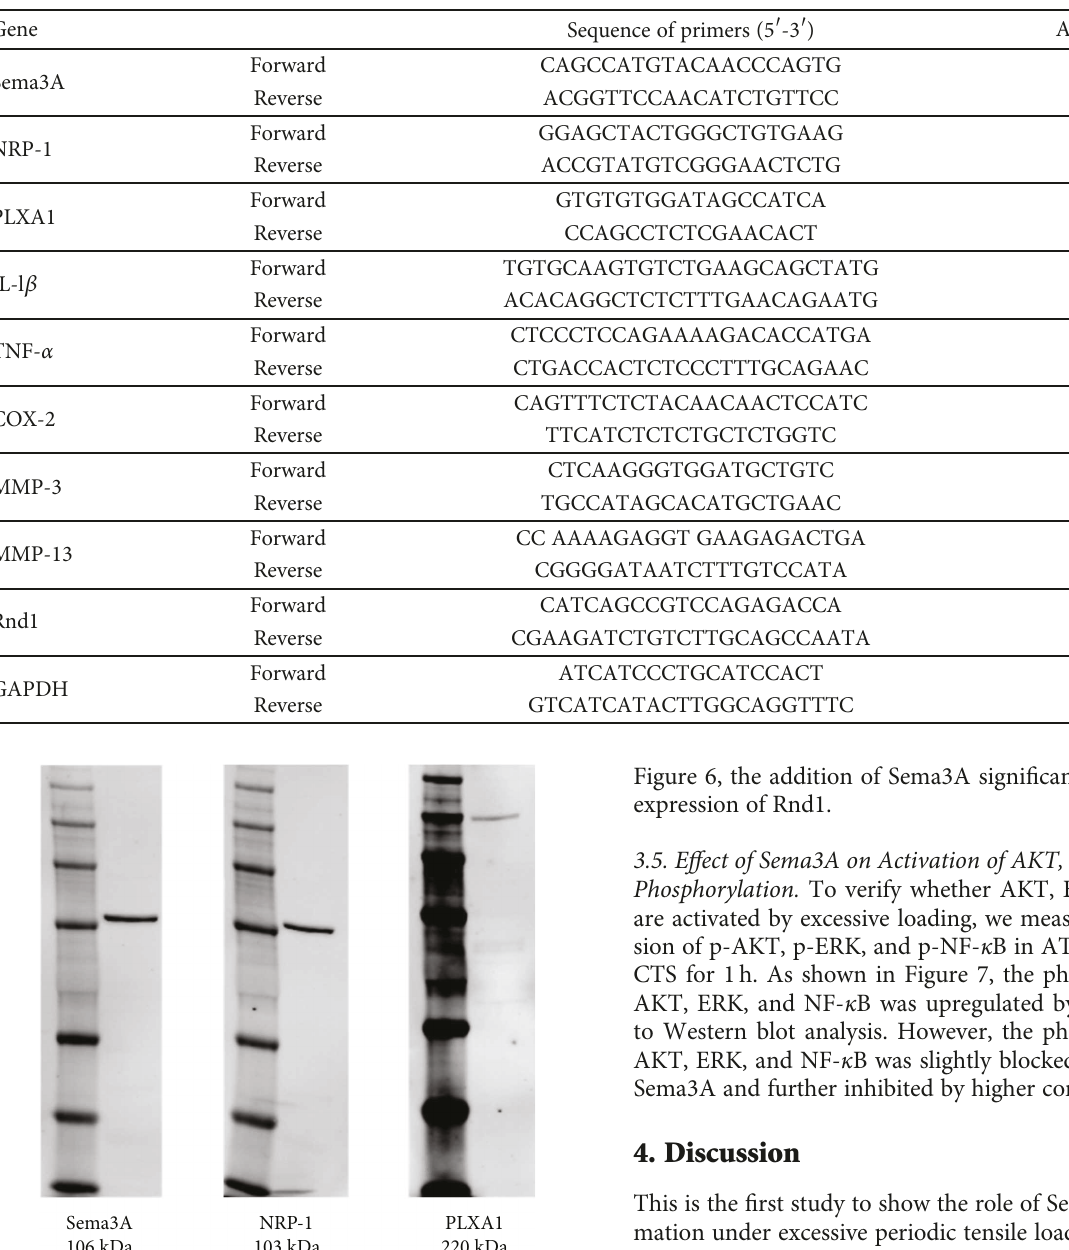
Table 1: The primer sequences for qPCR analysis.